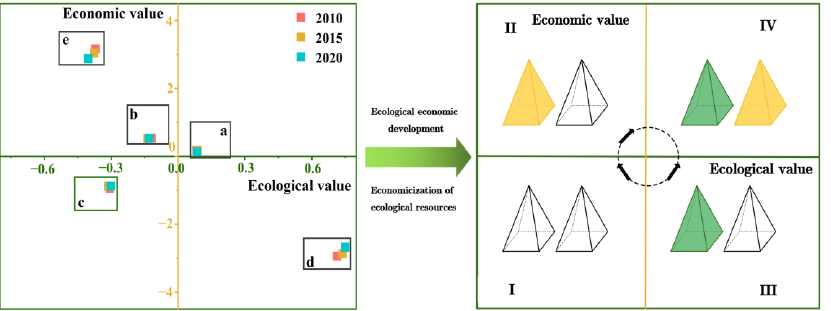
Figure 12. Spatial zoning optimization map of land consolidation with matching ecological-economic values. (Note: a is the middle karst basin area of Guangxi, b is the southeast plain area of Guangxi, c is the northeast hilly mountain area of Guangxi, d is the northwest mountain area of Guangxi, e is the coastal hilly plain area. I indicates the type of low ecological-economic value imbalance, II indicates the type of ecological value imbalance, III indicates the type of economic value imbalance, and IV indicates the type of coordinated ecological-economic value development.)